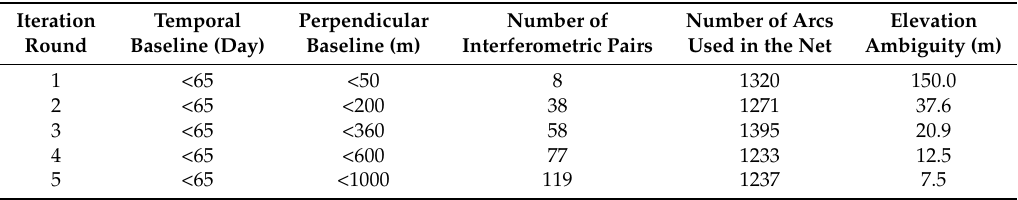
Table 2. Interferometric perpendicular baseline thresholds in a long–short baseline permanent scatterer interferometric synthetic aperture radar (PSInSAR)